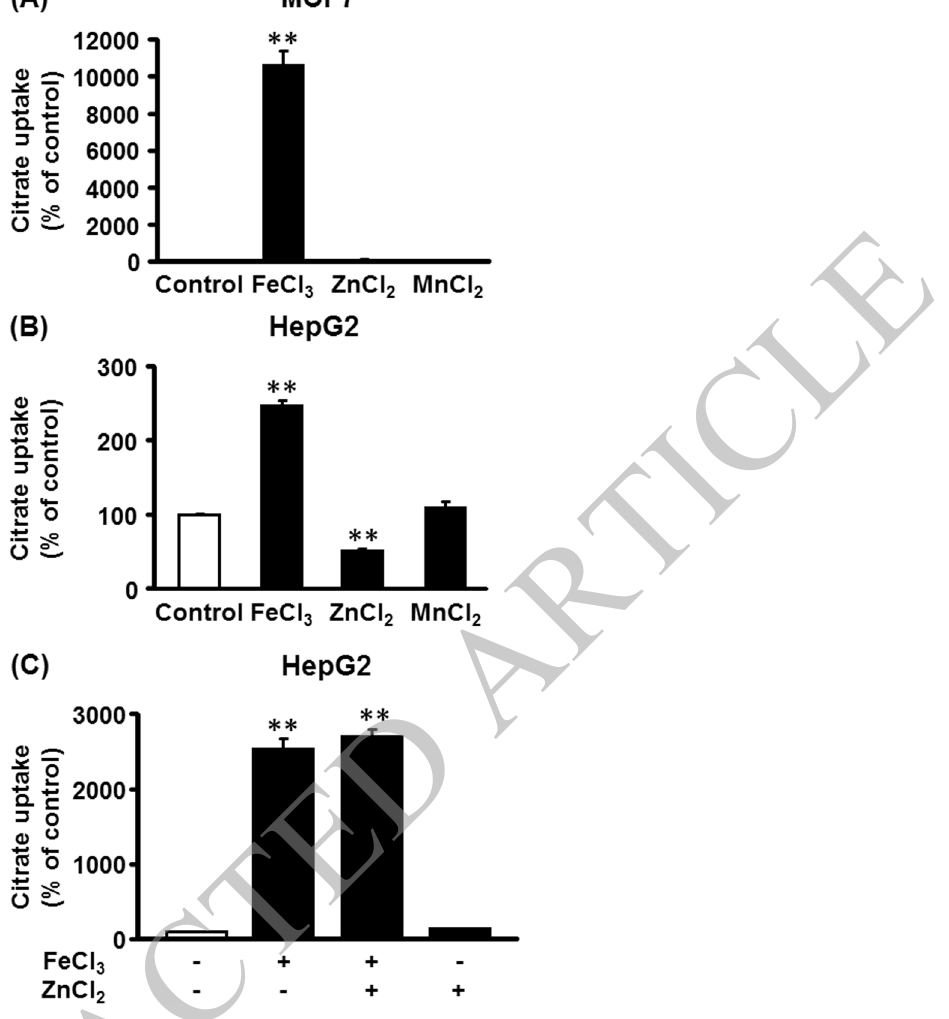
Figure 8. Effect of Zn 2 + and Mn 2 + on citrate uptake in MCF7 and HepG2 cells in the presence of Na + . MCF7 cells ( A ) and HepG2 cells ( B ) were cultured to confluence and the cells were used to measure the uptake [ 14 C]- citrate (3.5 μ M) for 15 min in the presence (NaCl buffer, pH 7.5) with FeCl 3 (50 μ M), ZnCl 2 (50 μ M), or MnCl 2 (50 μ M). ( C ) HepG2 cells were cultured to confluence and the cells were then used to measure the uptake of [ 14 C]-citrate (3.5 μ M) for 15 min in the presence (NaCl buffer, pH 7.5) and in the presence or absence of FeCl 3 (50 μ M) or ZnCl 2 (50 μ M) as indicated. The results are given as percent of control uptake measured in the absence of FeCl3. ** p <